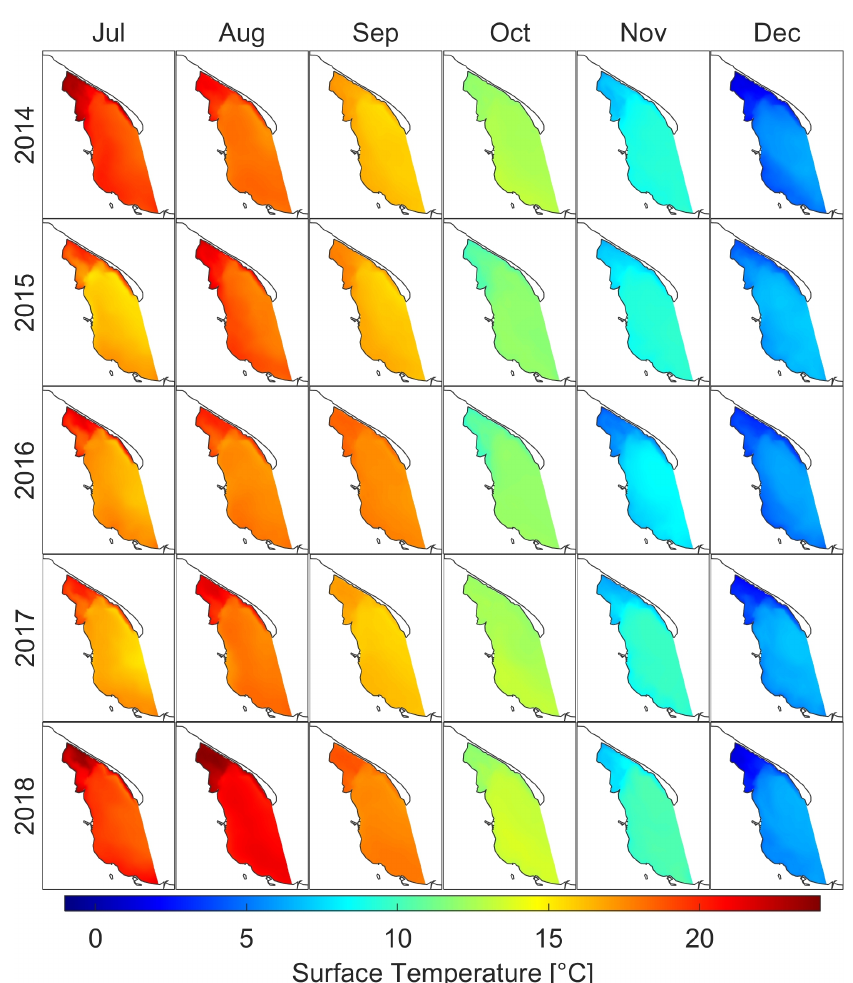
Figure A9. Monthly means of water temperature at sea surface for separated years. July to December.